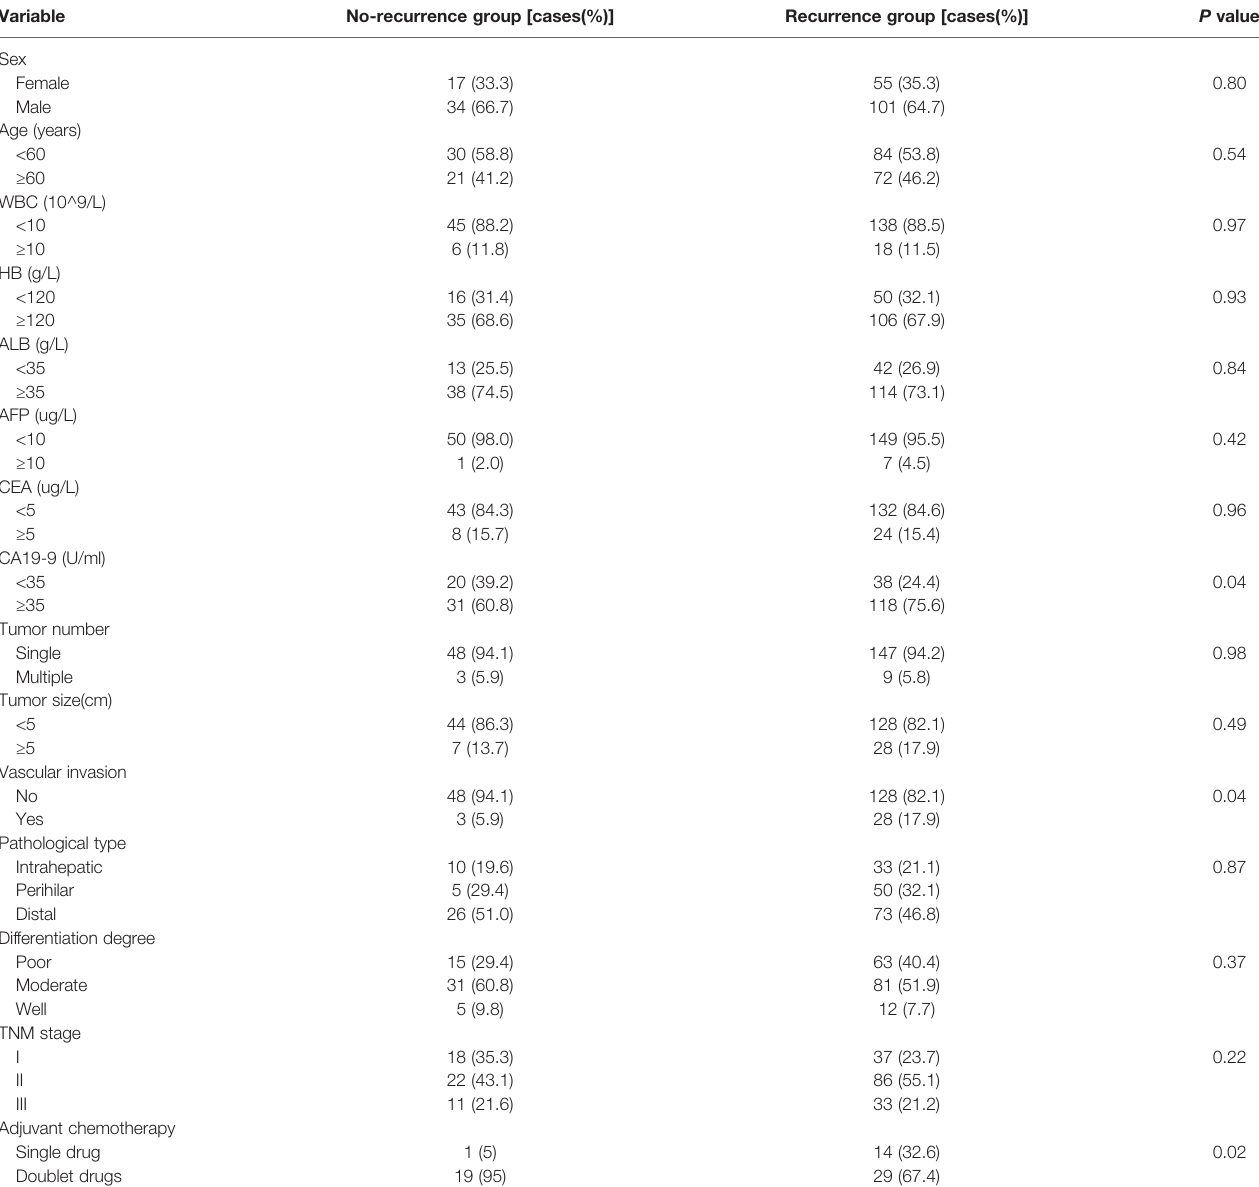
TABLE 1 | Chi-square test results of the correlation between the clinical pathological factors and recurrence of cholangiocarcinoma after radical surgery.